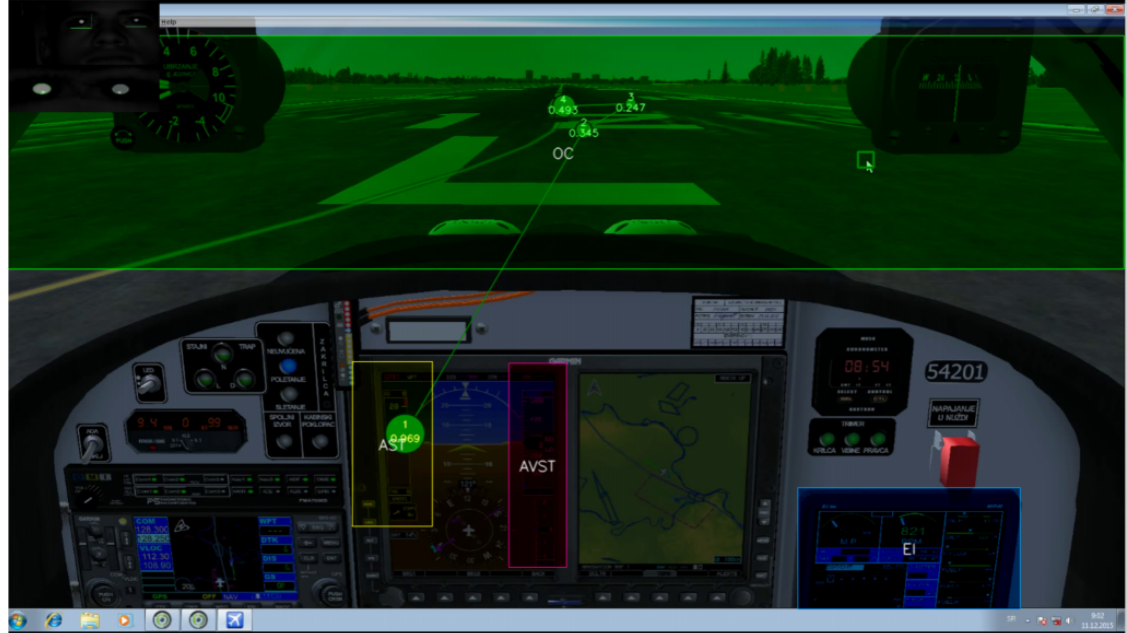
Figure 12. Position of Areas of interest (AOIs.) Fixations No26 to No32, during 3 second period. Gaze point analyzer was set up to refresh display with gazes on every 3 seconds. Participant P5 example.